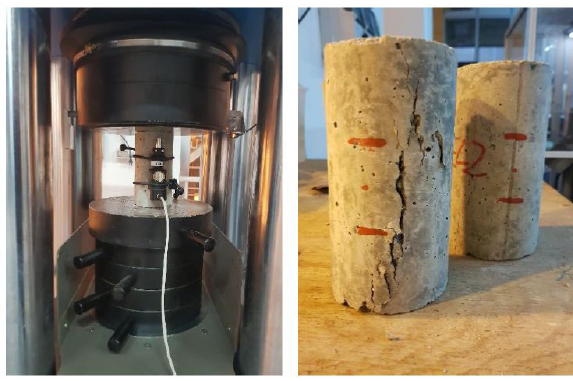
Figure 7: Determination of Young’s modulus in accordance with UNI 6556 on concrete cylinders